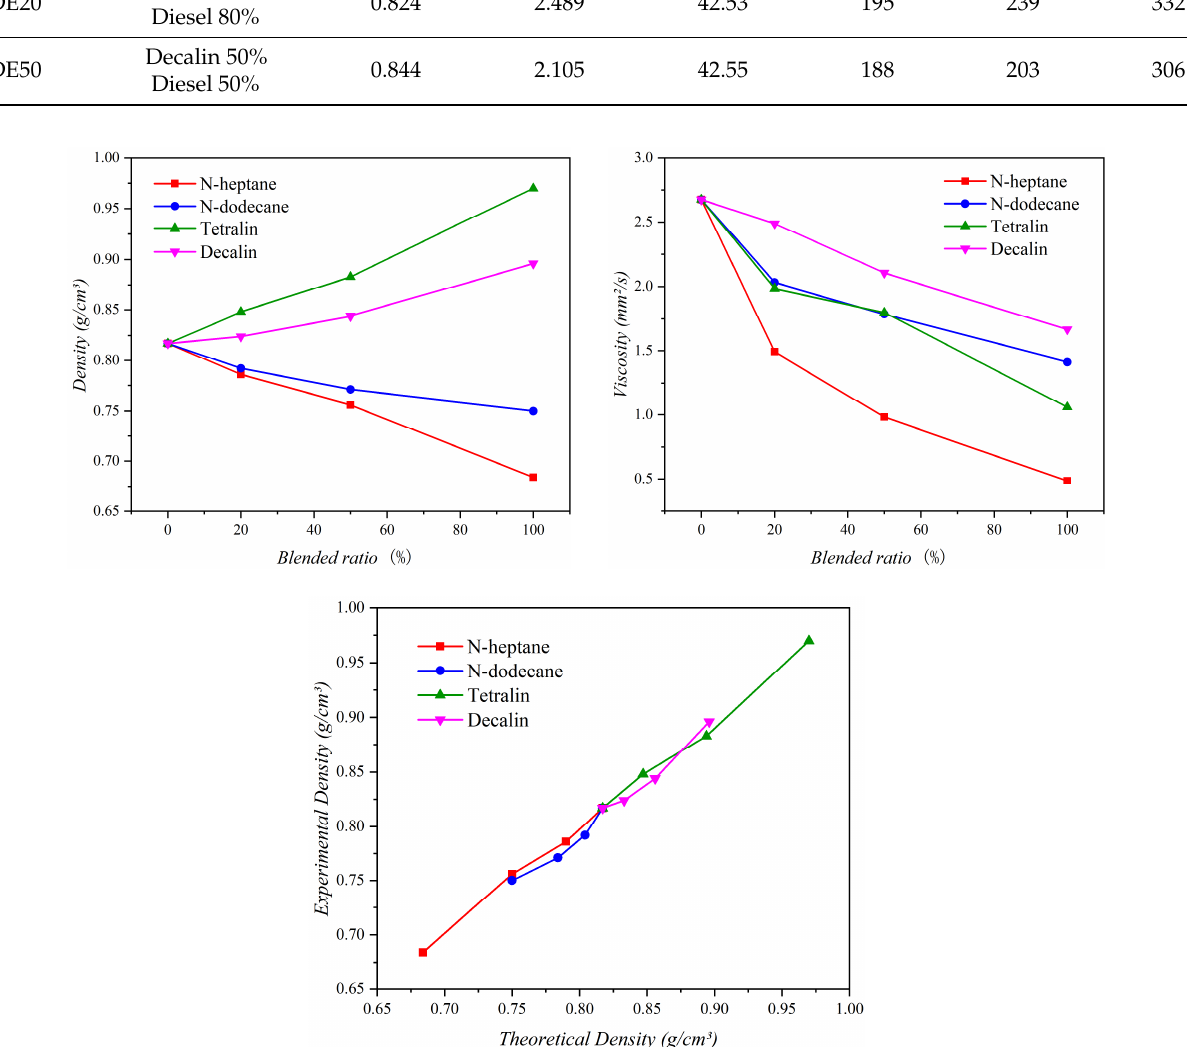
Figure 2. The experimental fuels’ density and viscosity. Table 2. Main properties of test fuels.